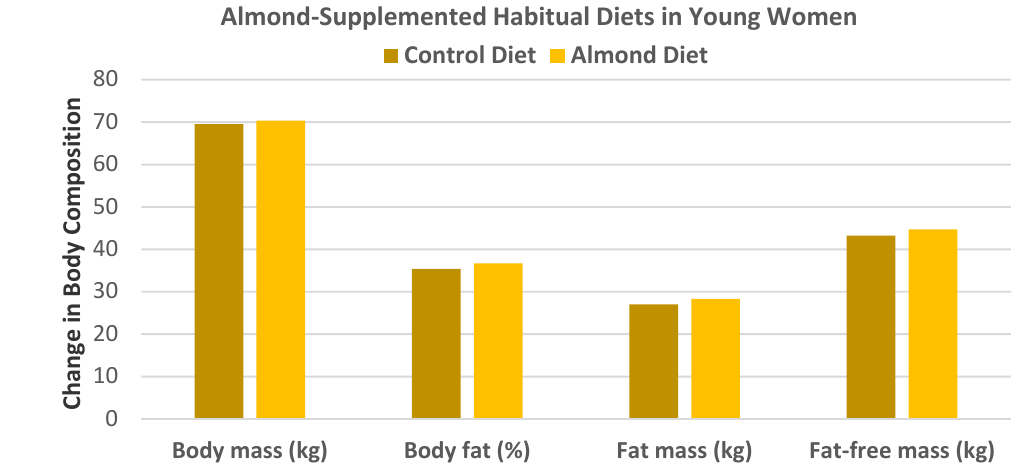
Figure 3. Changes in body weight and composition measures after 60 g (344 kcals) raw almonds/day are added to the habitual diets of young women compared to the habitual diet control over 10 weeks ( p > 0.05) [31].